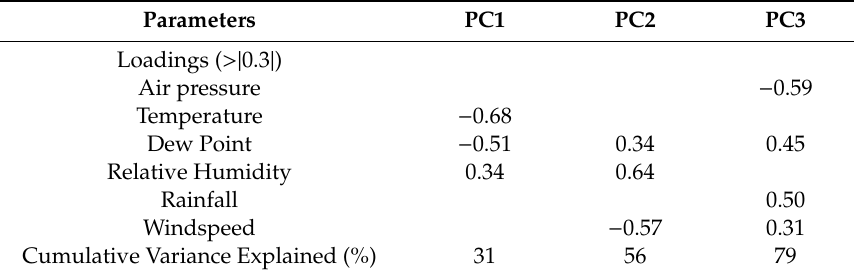
Table 3. Principal Component Analysis (PCA) on weather variables. PC1, PC2, PC3 are Principal axes 1, 2, and 3,